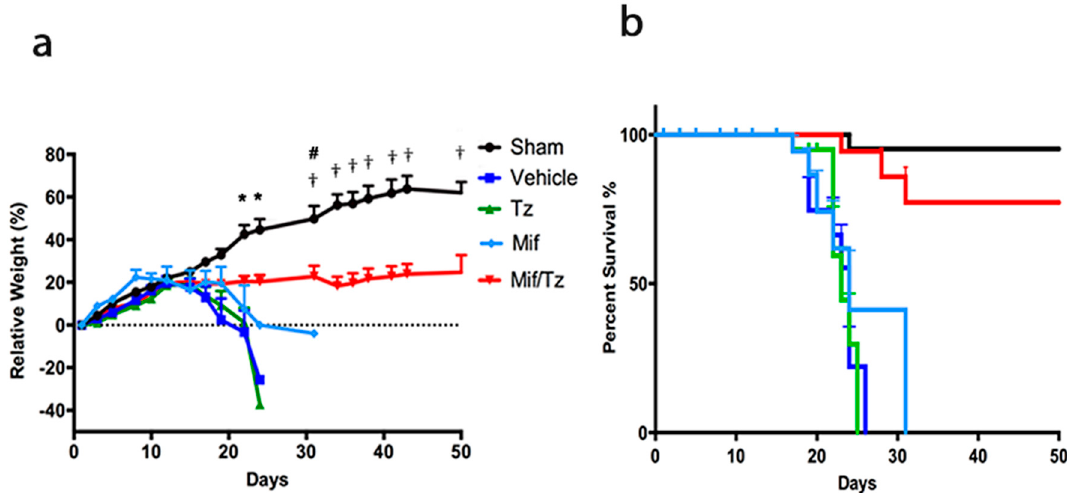
Figure 2. The effect of tumor growth in the orthotopic rat model of a glioma, evaluated by weight loss and overall survival. ( a ) Relative weight of rats in the five groups: sham surgery (without implanting glioma cells) ( ● ), and the implantation of glioma cells followed by each of the treatments: vehicle only ( ● ), temozolomide only ( ● ), mifepristone only ( ● ), and the mifepristone/temozolomide combination ( ● ). Each point represents the mean ± SEM of six animals. * A significant difference ( p < 0.05) between Mif/Tz and the other groups (Sham, Control, Tz only and Mif only) on day 24. # A significant difference ( p < 0.05) between Mif/Tz and Mif only on day 31. † A significant difference ( p < 0.05) between the Mif/Tz and the Sham group on day 31. ( b ) Survival analysis of the same groups for up to 50 days after implantation (day 0 = day of surgery).